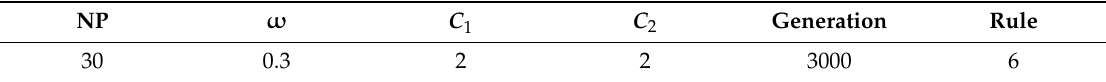
Table 5. DGCPSO initialization parameter setting.